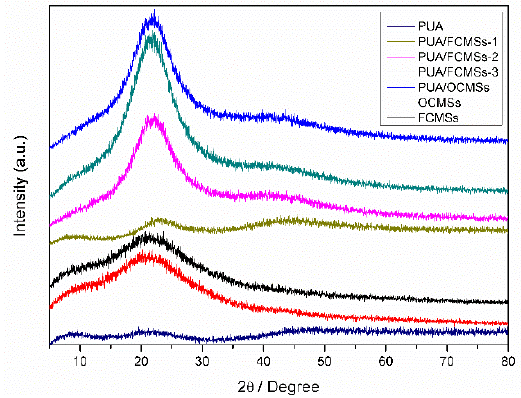
Figure 12. X-ray diffraction images of OCMSs and FCMSs.